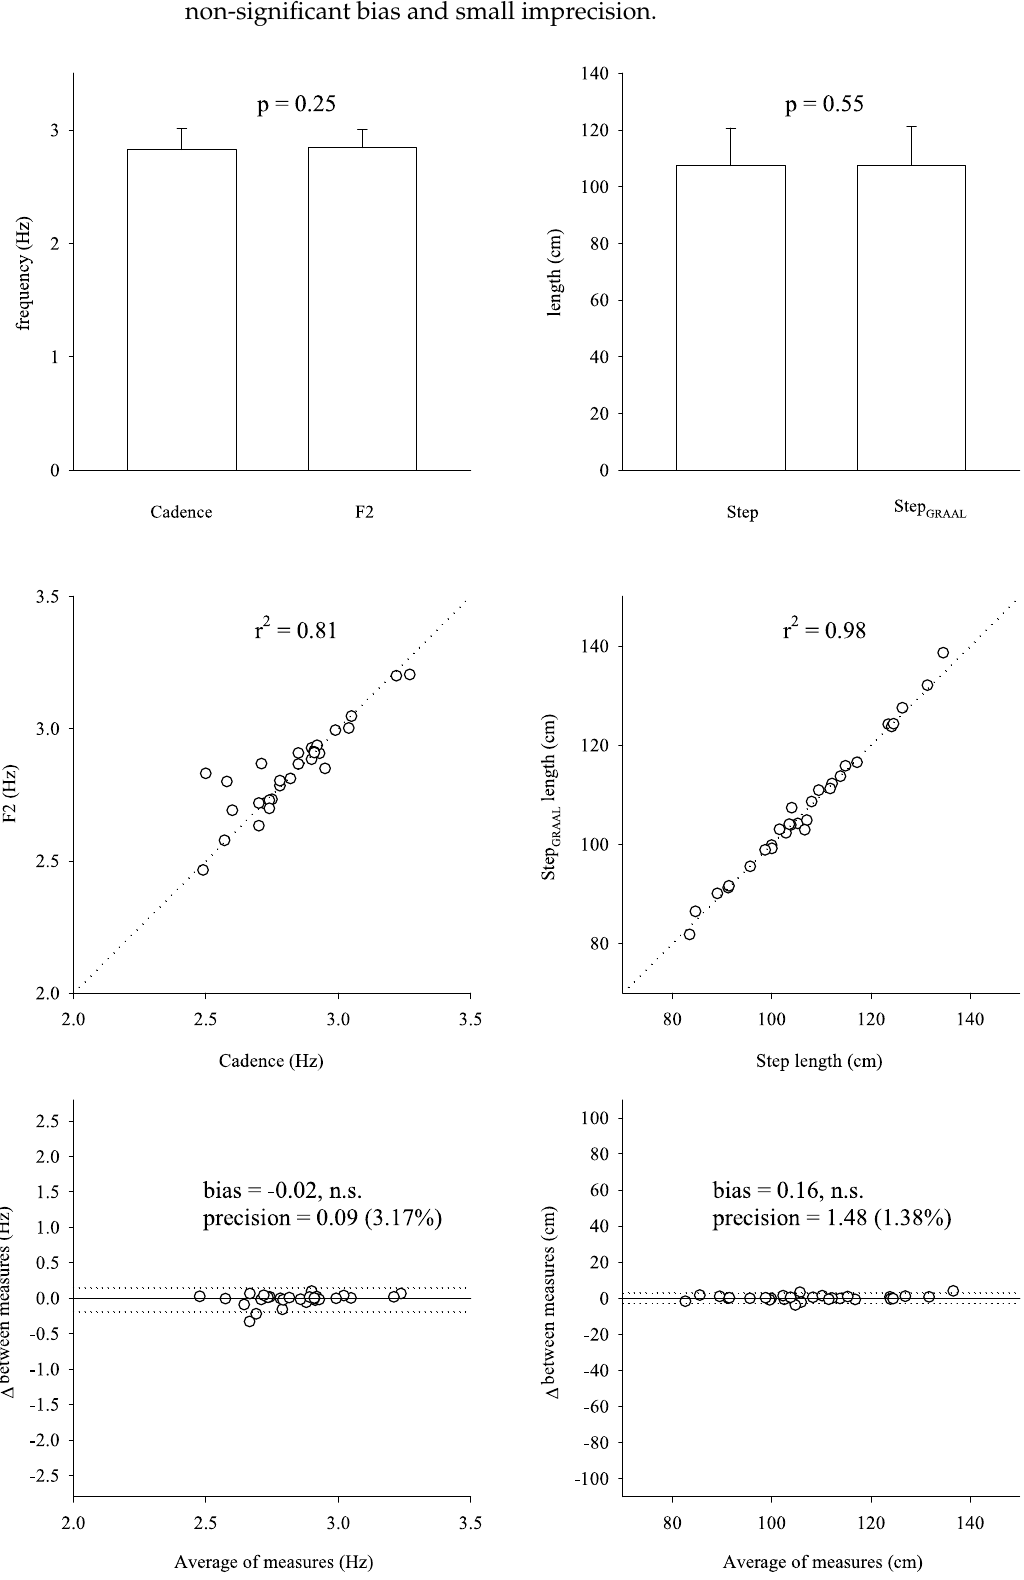
Figure 4. From the top down: histograms, scatterplots, and Bland–Altman plots of cadence vs. F2 frequency (left side) and step length vs. Graal step length comparing measurements by Optogait against those by Graal.